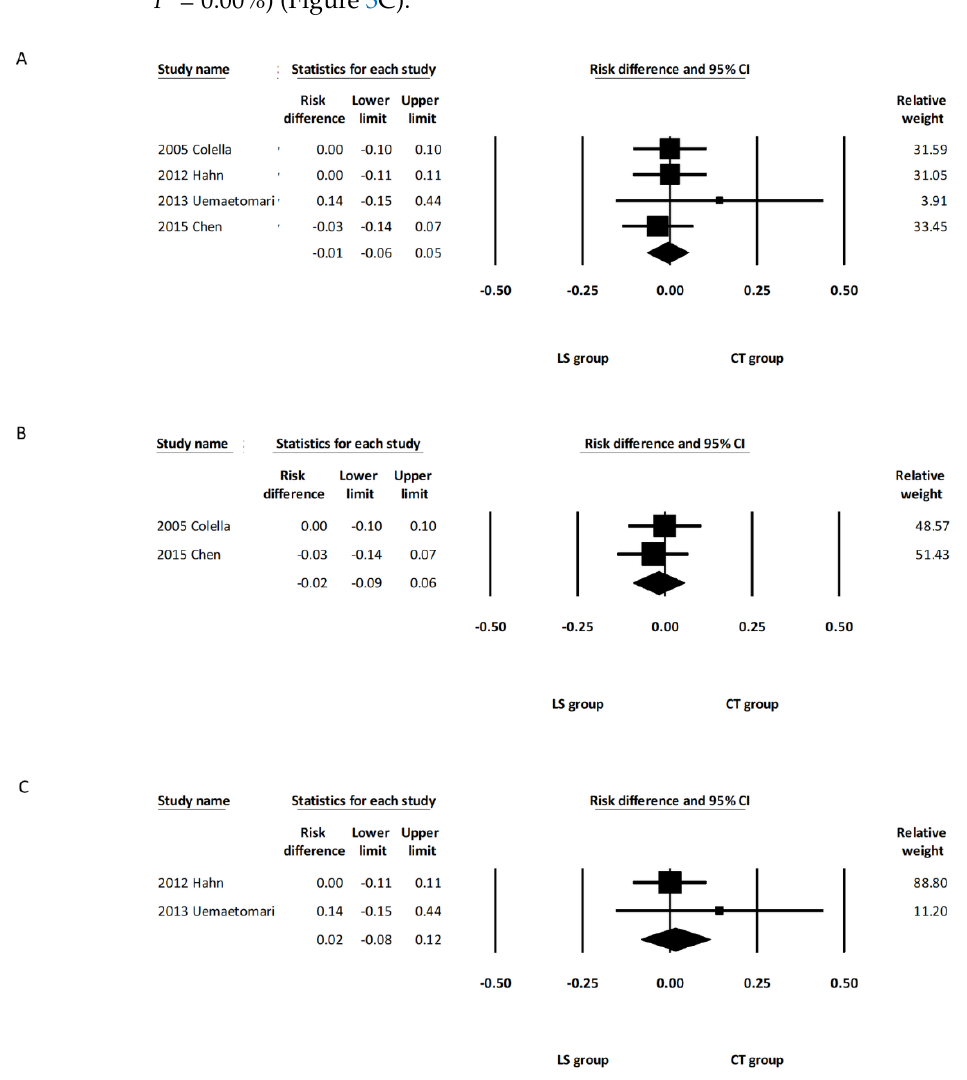
studies reported the incidence of temporary facial palsy [11 – 15]. Meta-analyses were car-